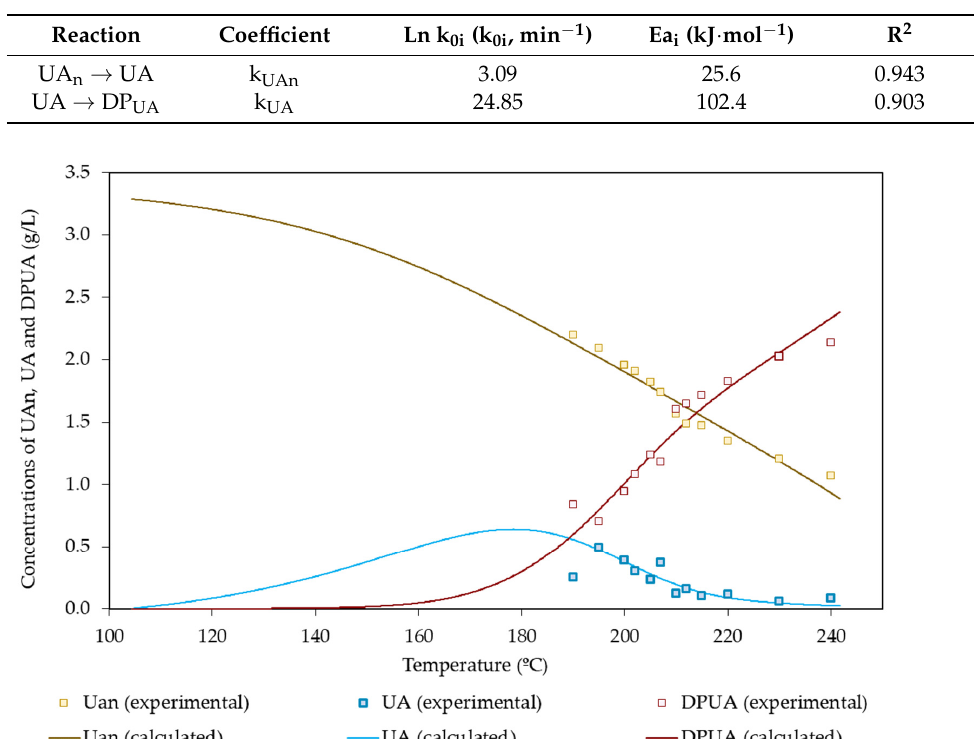
Table 8. Results calculated for the parameters governing the reactions of uronyl groups and the derived products.